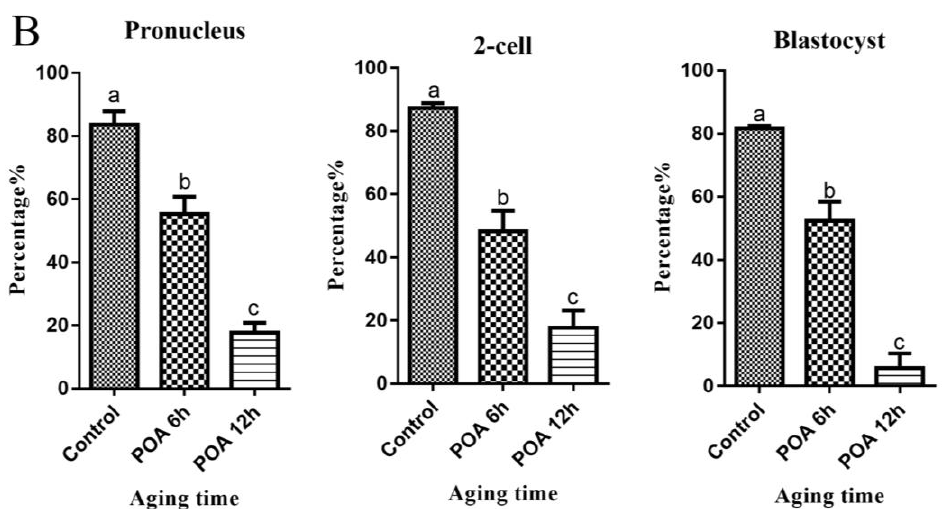
Figure 1. Postovulatory aging (POA) in vitro reduces the rates of fertilization and early embryo development of mouse oocytes. ( A ) Representative images of pronucleus, 2-cell and blastocyst in the control, POA 6 h and POA 12 h groups. The white arrow indicates pronucleus, the black arrow indicates 2-cell and the black triangle indicates blastocyst. Scale bar = 100 µ m. ( B ) The rates of pronucleus, 2-cell and blastocyst in the control, POA 6 h, and POA 12 h groups. Data are presented as mean ± SEM from at least three independent experiments. a – c means not sharing a common superscript are different ( P < 0.05).